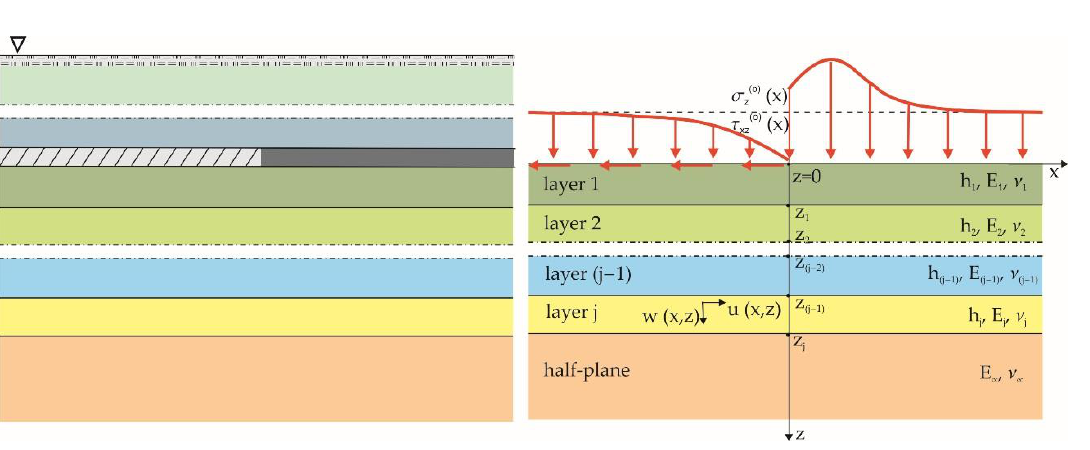
Figure 2. A geomechanical model of the stratified rock mass.